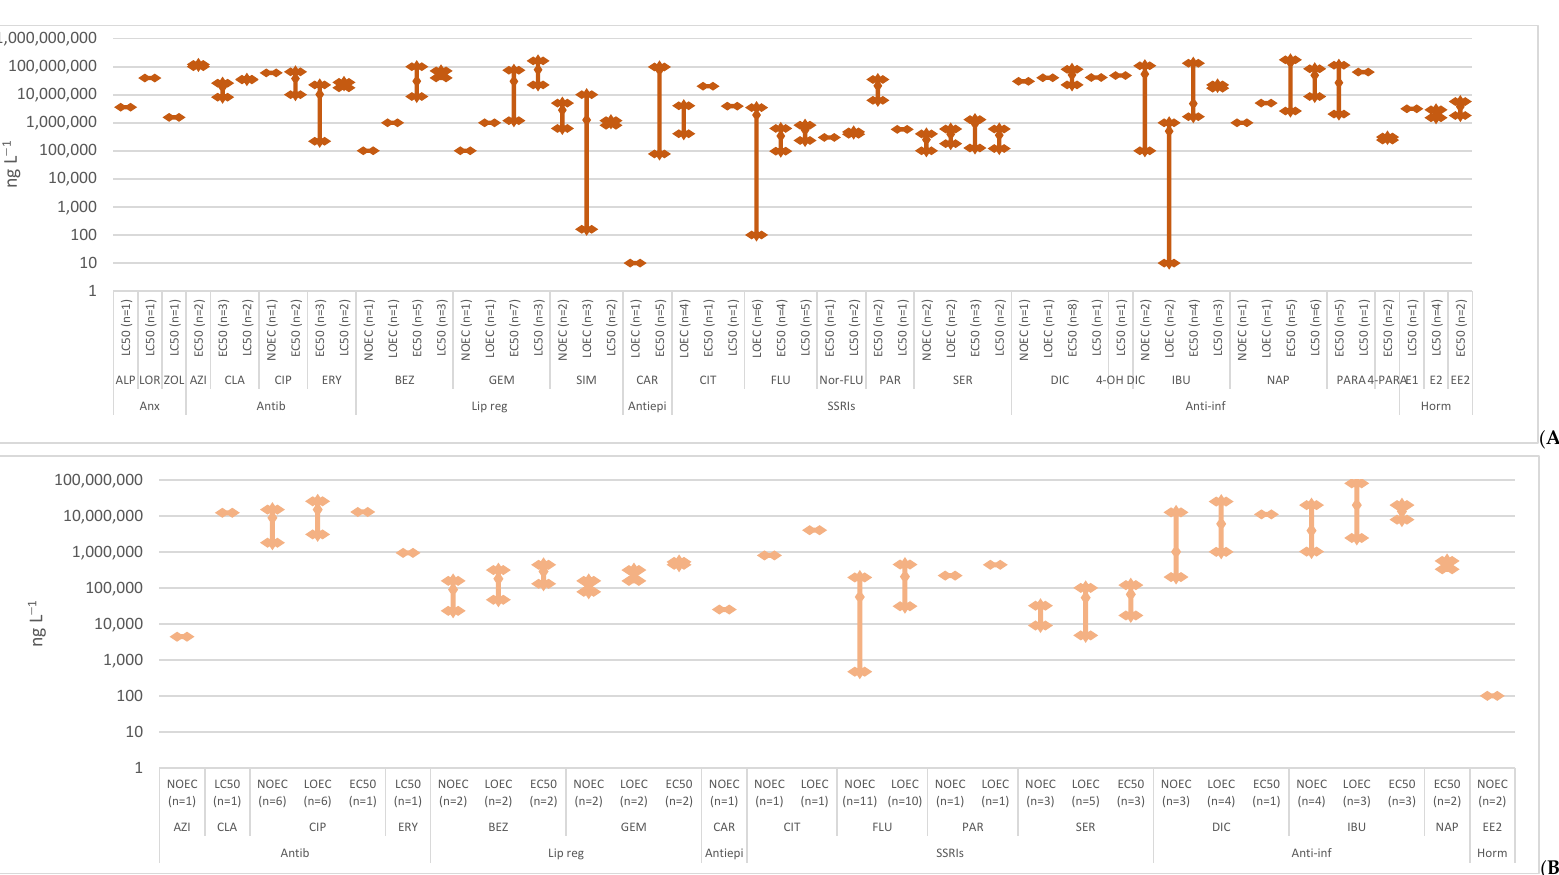
Figure 2. Median, maximum and minimum concentration values reported for acute ( A ) and chronic ( B ) toxicity data concerning